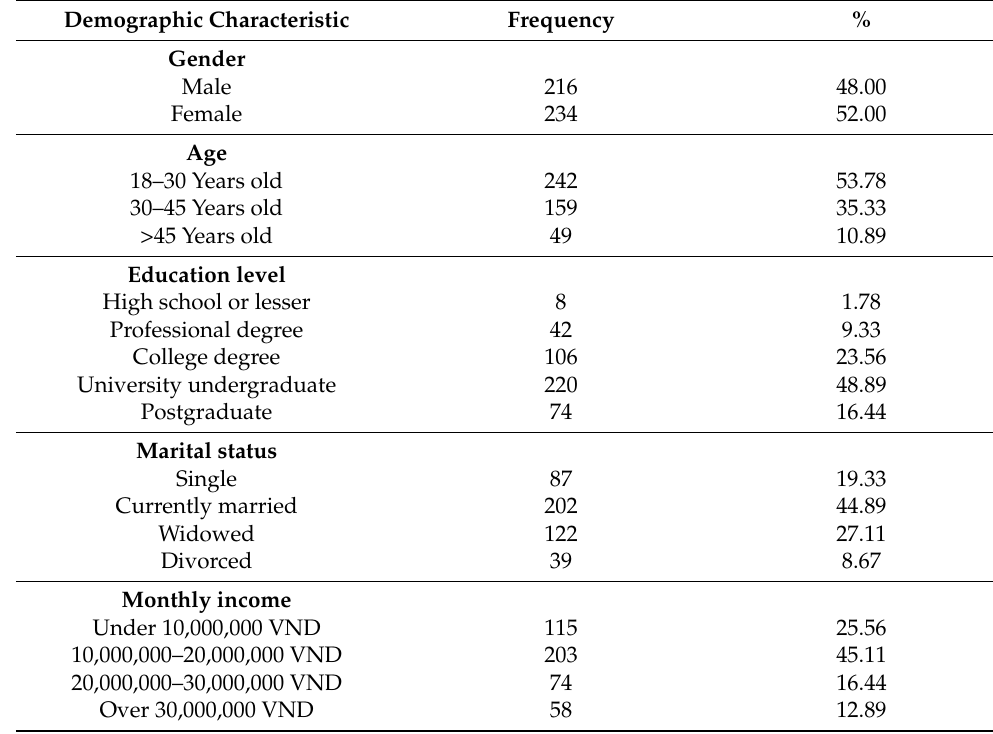
Table 1. Demographic profile of the